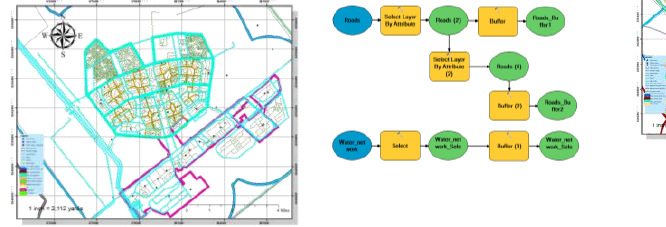
Figure 4. Water supply and Management